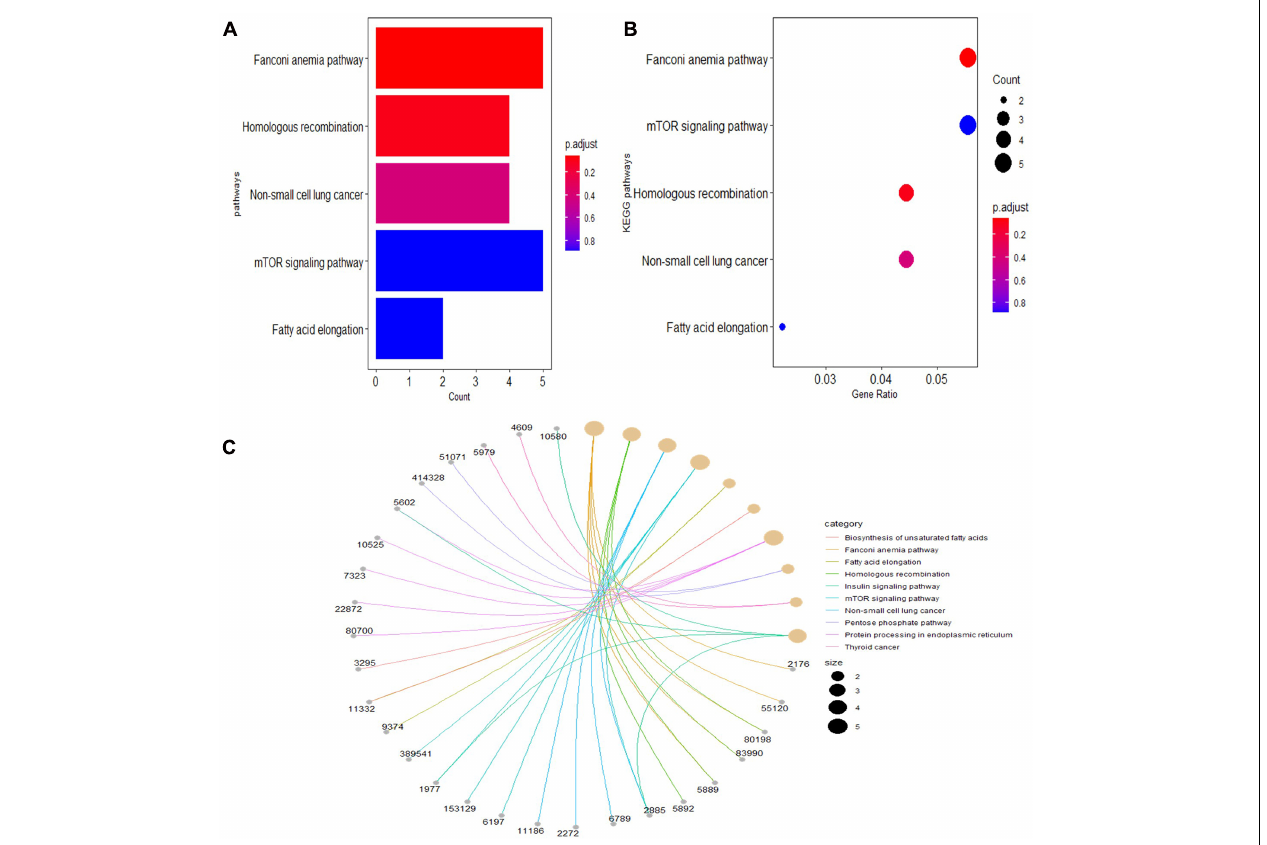
FIGURE 4 | The top 5 enriched Kyoto Encyclopedia of Genes and Genomes (KEGG) pathway terms of differentially expressed genes. (A) Bar chart of the top 5 KEGG pathways in the enrichment analysis. (B) Bubble map of the top 5 KEGG pathways in the enrichment analysis. (C) Chord plot of the top 5 KEGG pathways in the enrichment